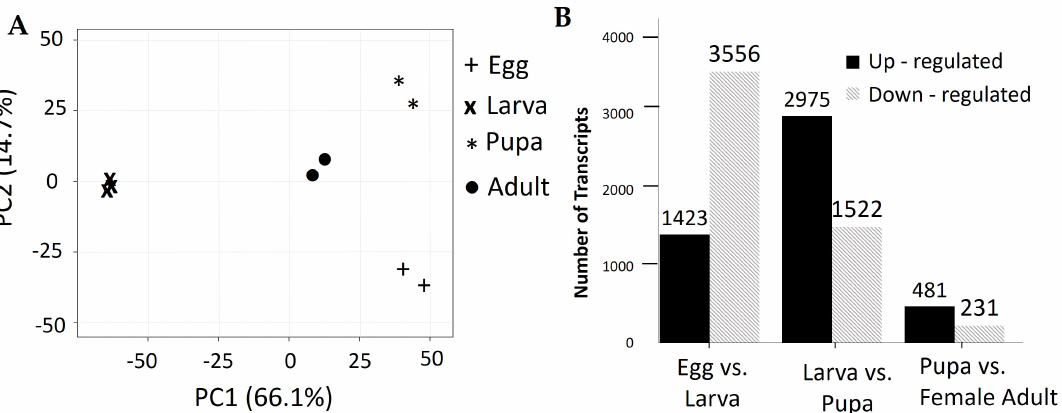
Figure 7. Comparison of transcriptional profile of each developmental stage of M. plana ( A ) Principal component analysis (PCA) was conducted using web-based ClustVis software [45] based on normalised (FPKM) and log-transformed count data from nine biological samples of M. plana . Principal component 1 (PC1) has 66.1% variance while principal component 2 (PC2) has 14.7% sample variance. ( B ) Number of up-regulated and down-regulated transcripts in each pairwise comparison of egg-larva, larva-pupa and pupa-adult (FDR <0.001, |Log2FC| ≥ 2).